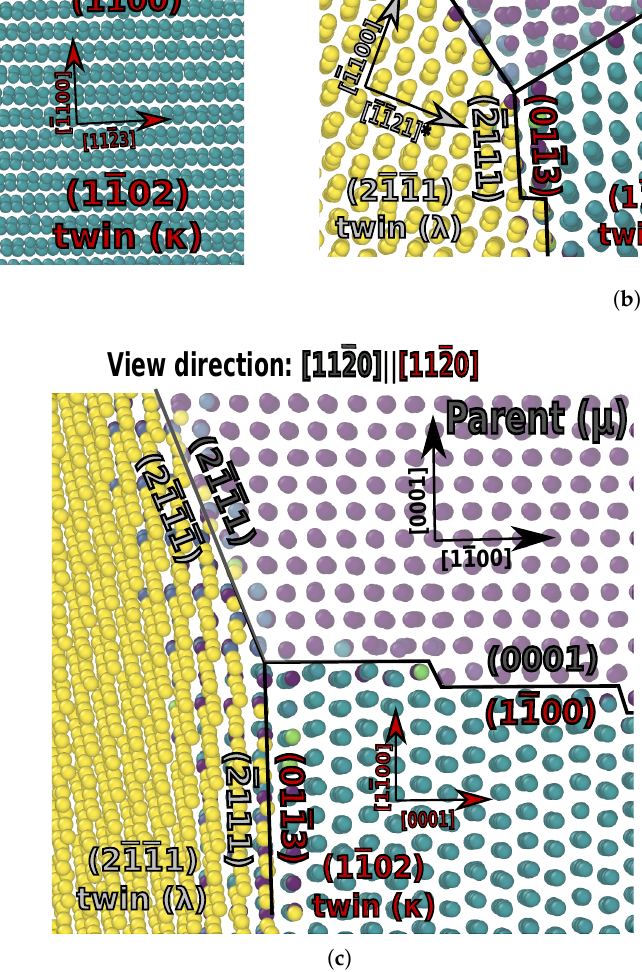
Figure 8. Twin–twin interaction between ( 2111 ) and ( 1102 ) twins. Three points of view for the interaction are displayed to aid characterization. The ( 1102 ) twin interface is a basal-prismatic boundary as can be identified in ( a , c ). The ( 2111 ) twin plane boundary can be identified from ( a , b ), as can the new interface between the